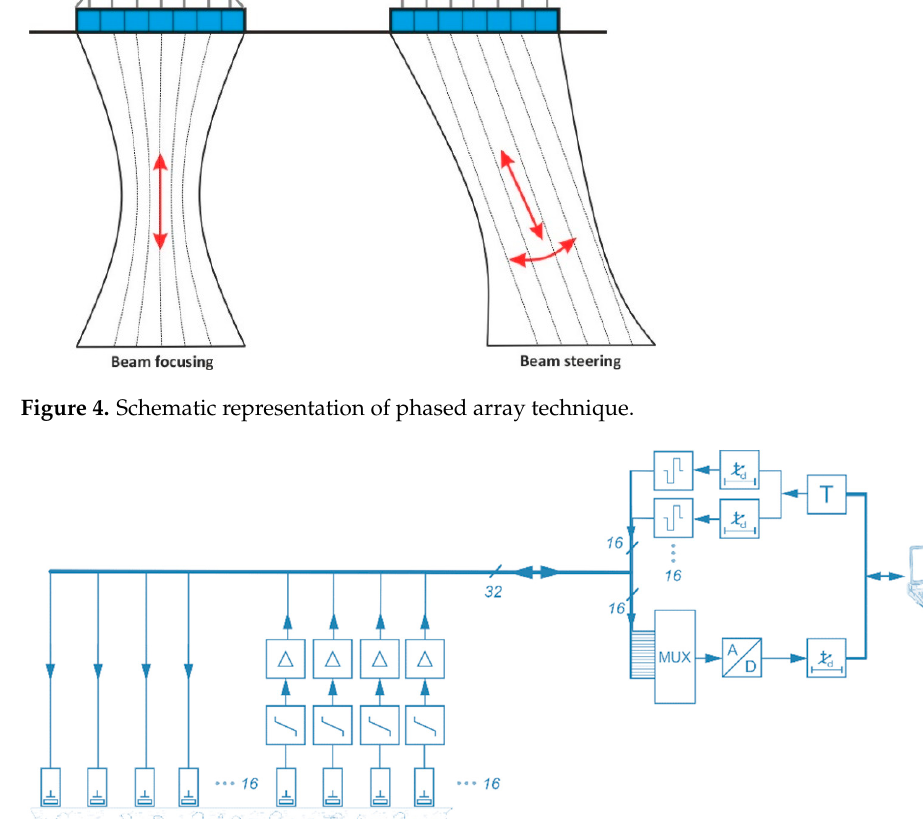
Figure 5. Block diagram of ultrasonic phased array system with borehole probe.